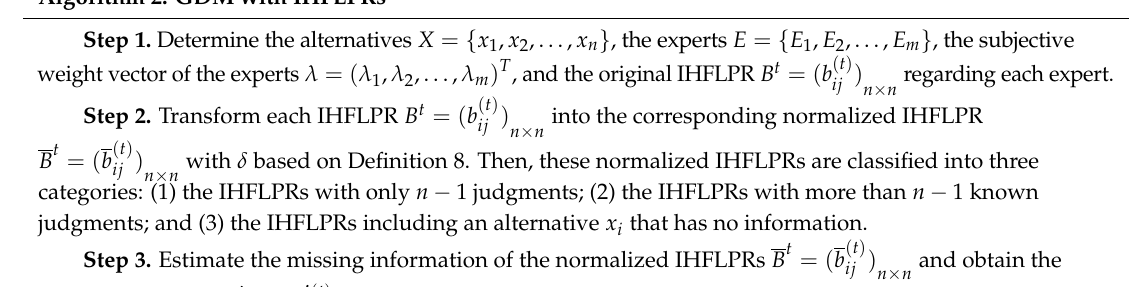
Algorithm 2. GDM with